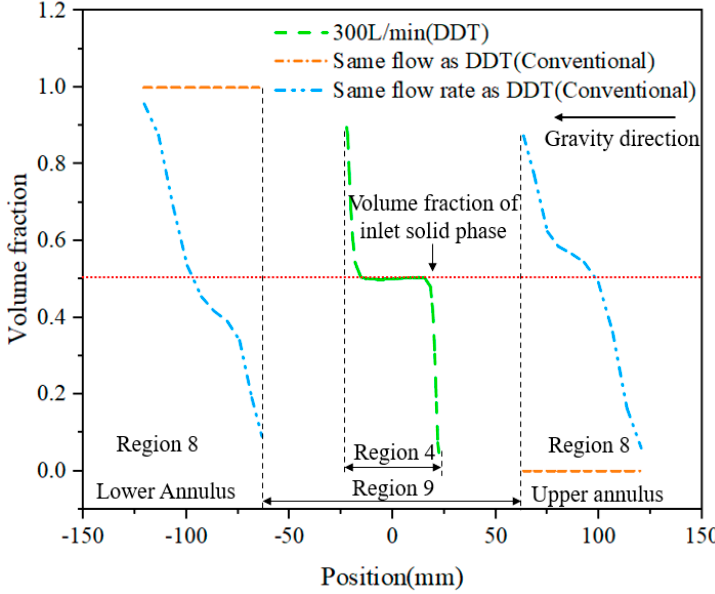
Figure 12. Comparison of two methods of migration under the same flow rate.